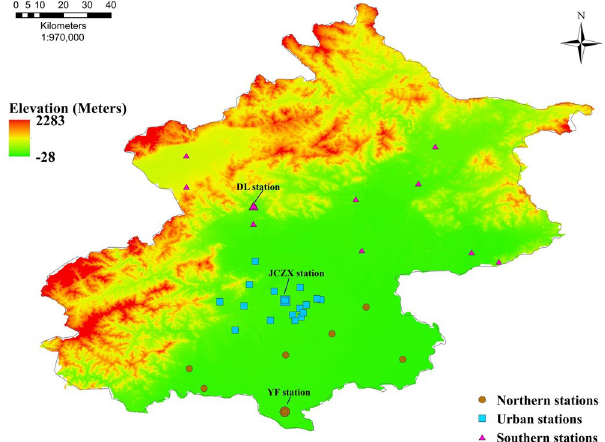
Figure 6. Categories and distributions of air quality observation stations in Beijing. This Map was generated using ArcGIS, Version 10.3